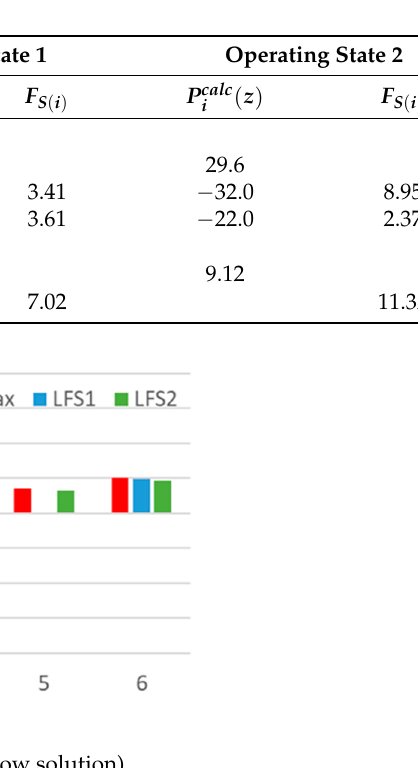
Figure 6. Diagram of active powers (LFS—load flow solution).